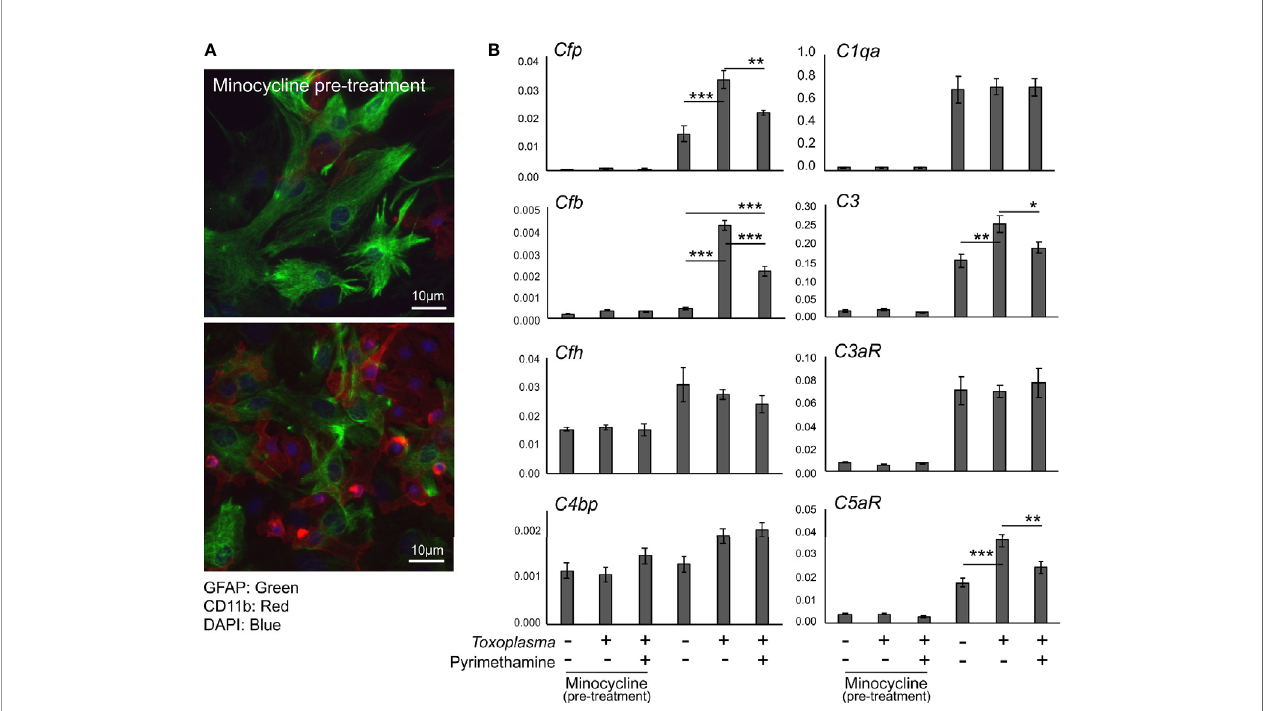
FIGURE 4 | Toxoplasma infection induced the upregulation of alternative complement pathway components and anaphylatoxin C5aR1. (A) Primary mixed glial cells prepared from the cortex of postnatal days 1 – 2 C57BL/6J mice. Astrocytes and microglia were detected by immuno fl uorescence microscopy, using Glial Fibrillary Acidic Protein (GFAP, green) and CD11b (red) as marker proteins. Cultures were pre-treated either in the presence or absence of minocycline (20 µM) for 5 days prior to T. gondii infection (upper panel). Without minocycline pre-treatment, glial culture contained signi fi cantly more CD11b positive microglia (lower panel). (B) mRNA levels of complement components ( Cfp , Cfb , Cfh , C4bp , C1qa , C3 , C3ar1 , and C5ar1 ) in glial cells with or without T. gondii infection in the presence or absence of anti- Toxoplasma drug pyrimethamine (2 µM). Means ± SEM. * p < 0.05, ** p < 0.01 *** p < 0.001 (Tukey ’ s